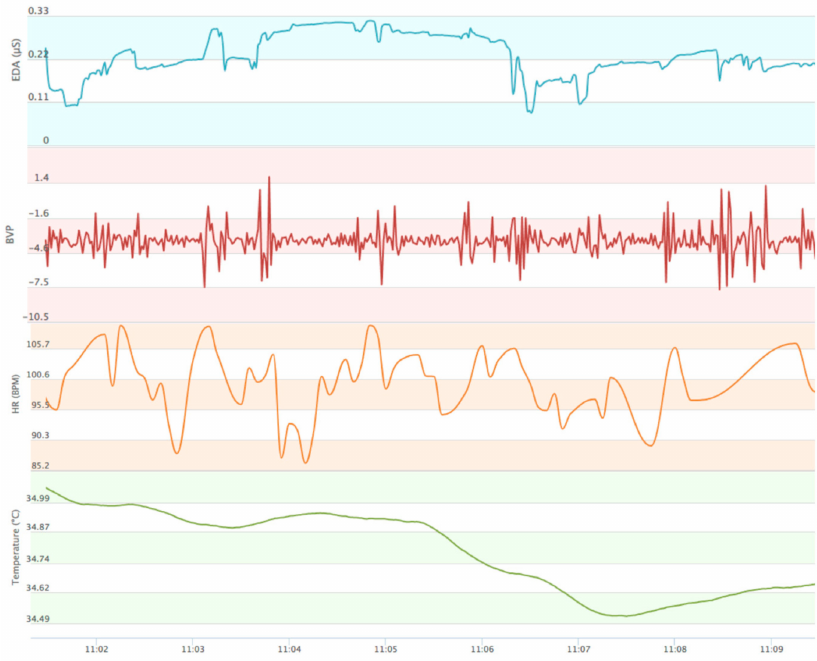
Figure 3. Example graph showing the output data from the activity bracelet: Electro Dermal Activity (EDA), Blood Volume Pulse (BVP), Heart Rate (HR), temperature and time (from top to